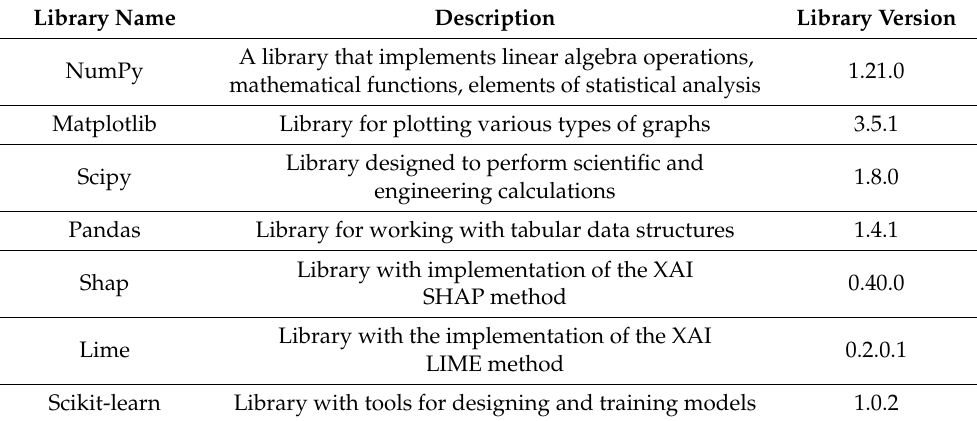
Table 4. Table of used